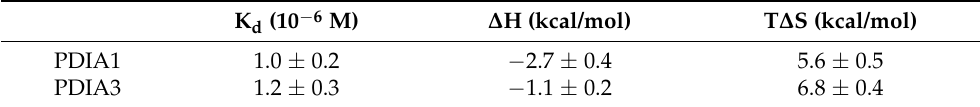
Table 2. Thermodynamic data of the interaction between punicalagin and PDIAs. Both proteins (25 10 − 6 M) were analyzed in reduced form. Affinity constant (K d ), molar enthalpy ( ∆ H), and entropy (T ∆ S) of the reaction at 25 ◦ C were calculated processing data obtained from the isothermal titration. K d (10 − 6 M) ∆ H (kcal/mol) T ∆ S